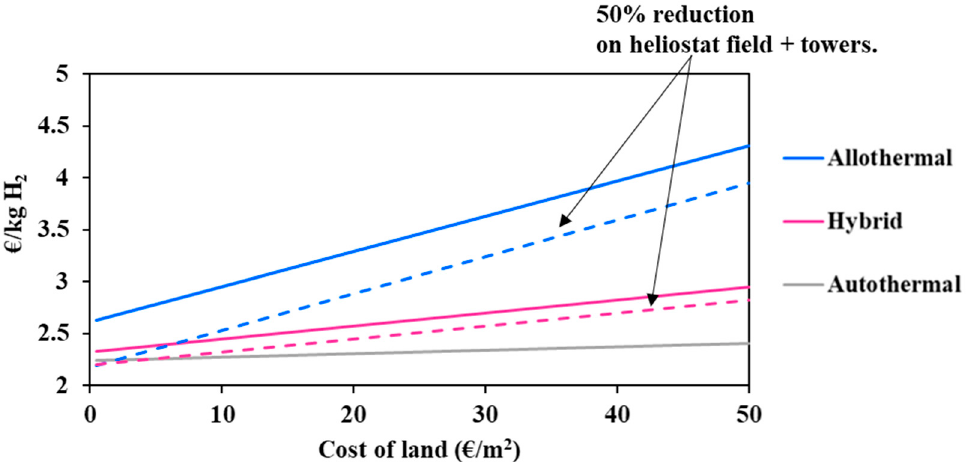
Figure 6. Impact of land cost on the hydrogen minimum price (solid lines: reference assumptions, Table 5; Chain-dotted lines: 50% cost reduction on heliostats and towers).